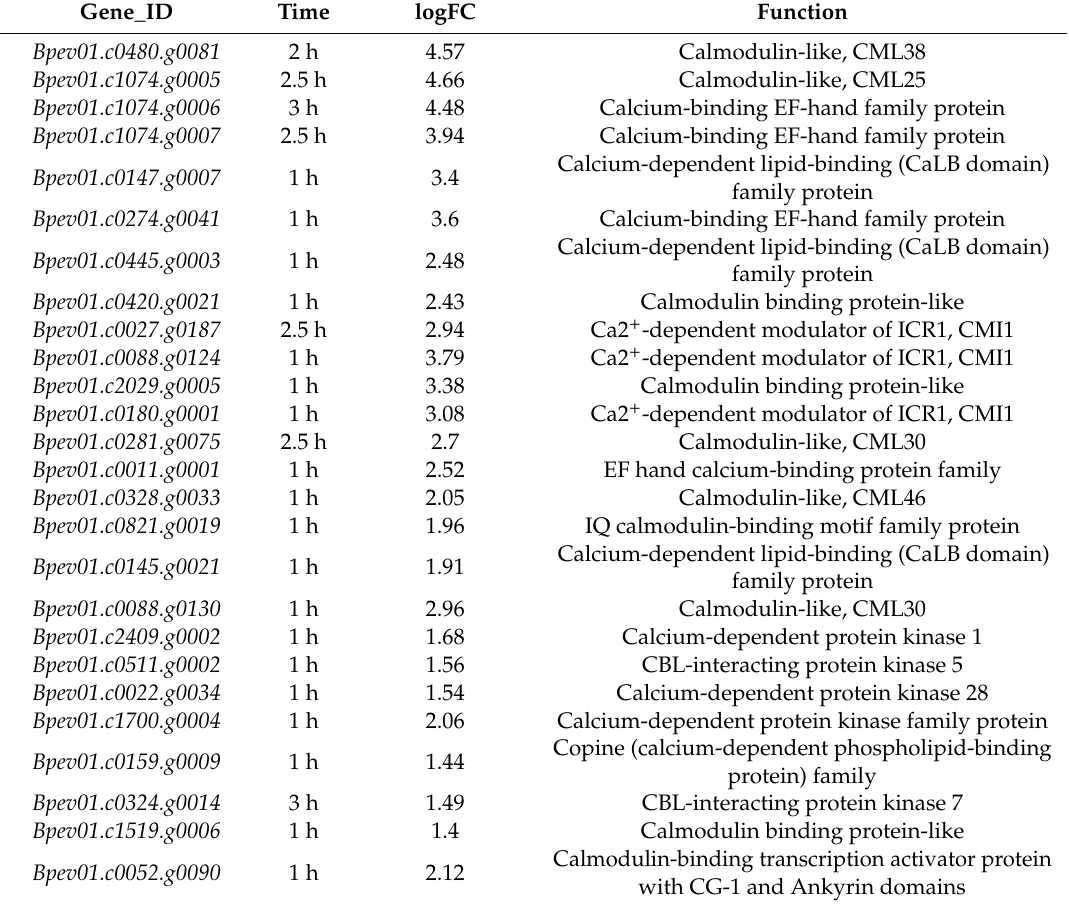
Table A4. DEGs were annotated for calcium signal pathway under low temperature stress in